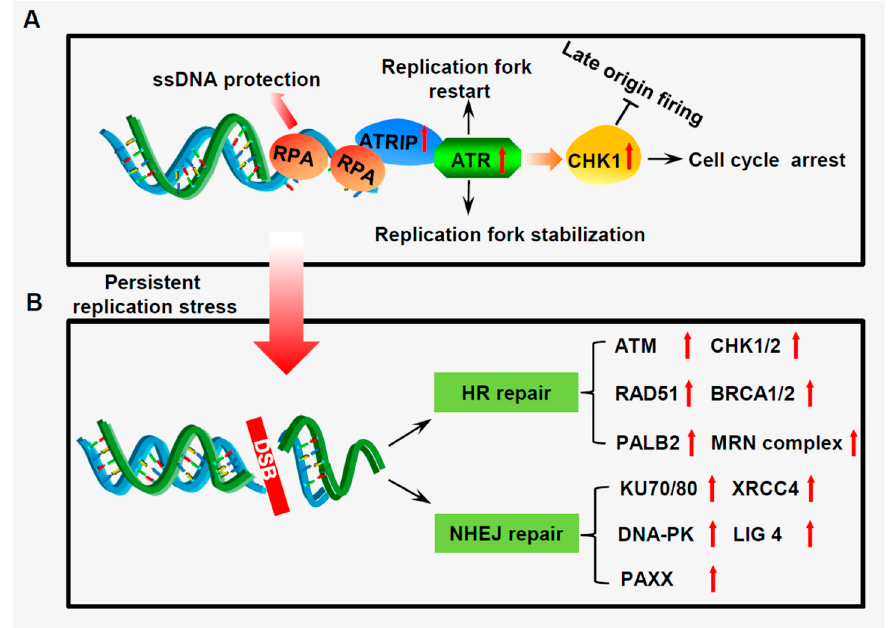
Figure 2. The DNA damage response network in SCLC cells. ( A ) The roles of the ATR-CHK1 signaling cascade in response to replication stress, replication protein A (RPA) is first loaded onto long stretches of single-strand DNA (ssDNA). The ATR was then recruited to the ssDNA sites through interaction with ATRIP. Once activated, ATR-mediated activation of CHK1 then transmits signals of replication stress through multiple mechanisms. ( B ) Once persistent replication stress cannot be fixed, replication forks then collapse into double-strand breaks (DSBs). In response to DSBs, SCLC cancer cells activate two major DSB repair pathways: Homologous recombination (HR) and non-homologous end joining (NHEJ). Crucial proteins involved in the HR repair pathway include BRCA1/2, CHK1/2, RAD51, ATM, etc.; the core components of the NHEJ repair pathway comprise KU70/80, XRCC4, DNA-PK, etc. Thus, constitutive activation of the replication stress response (RSR) pathway and DSB repair system is crucial for maintaining SCLC cell survival.